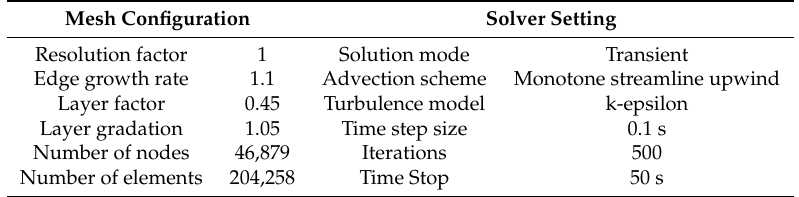
Table 4. Summary of parameters for the Computational Fluid Dynamic (CFD) simulation